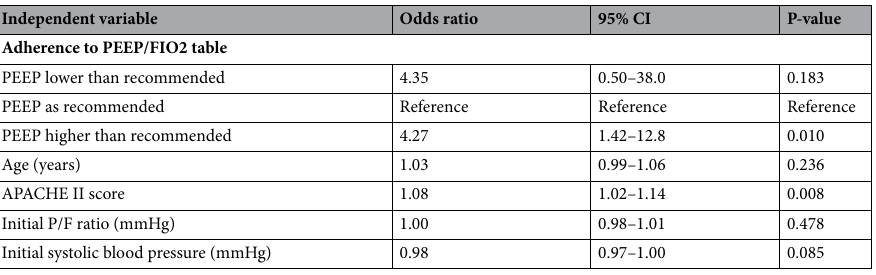
Table 5. Logistic regression for hospital mortality, by adherence to low PEEP/FIO2 table, for moderate-to- severe ARDS. Total number of patients with moderate-to-severe ARDS (initial P/F ratio ≤ 200 mmHg) =